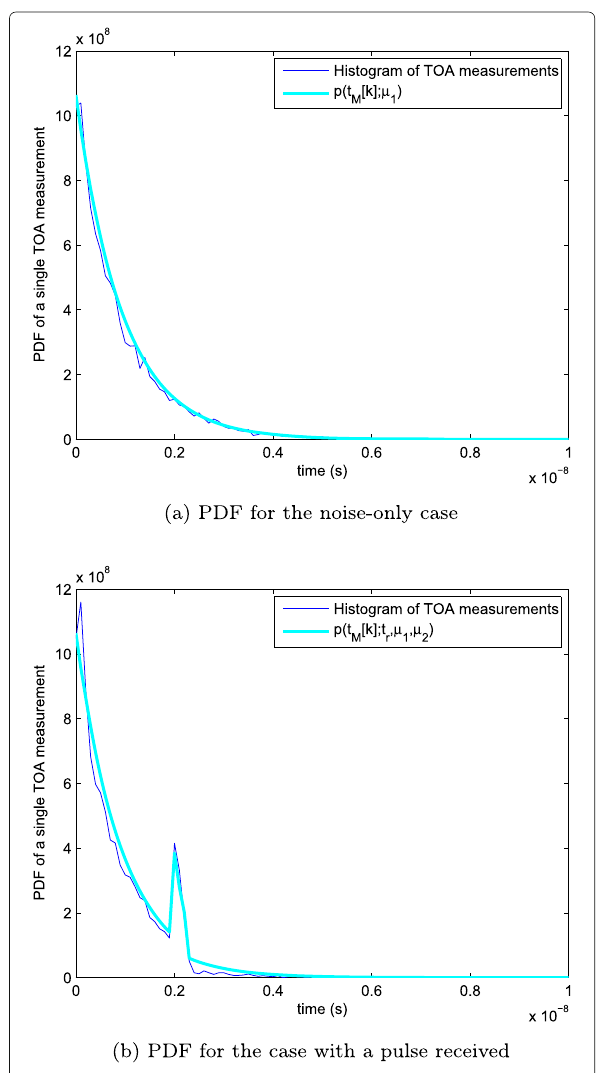
Fig. 4 PDF of the threshold-crossing moment for a the noise-only case, b the case with a single received FP pulse at t r = 2 ns and FPNR = 0.5 dB. The bandpass noise signal is white within f L = 3.1 GHz and f H = 6.1 GHz and V N /σ B = 1.7